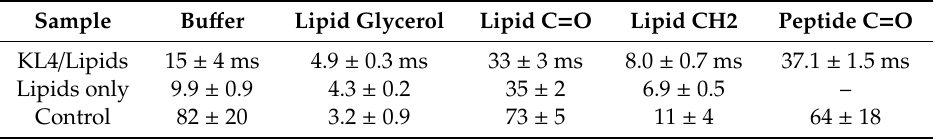
Table 3. 13 C T 2 relaxation times for di ff erent samples measured using a rotor-synchronized Hahn-echo sequence. All samples were comprised of 5.5 / 2.7 / 2 / 1 DPPC-d 62 / DPPC / POPG / cholesterol